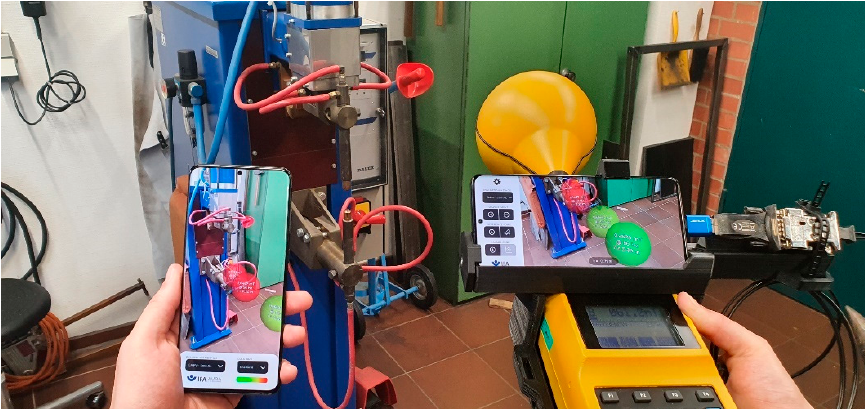
Figure 4. The Cloud Anchor functionality allows devices to share a common reference frame. By exchanging data about the objects in the scene, it becomes possible to view them independently from different perspectives with separate devices.